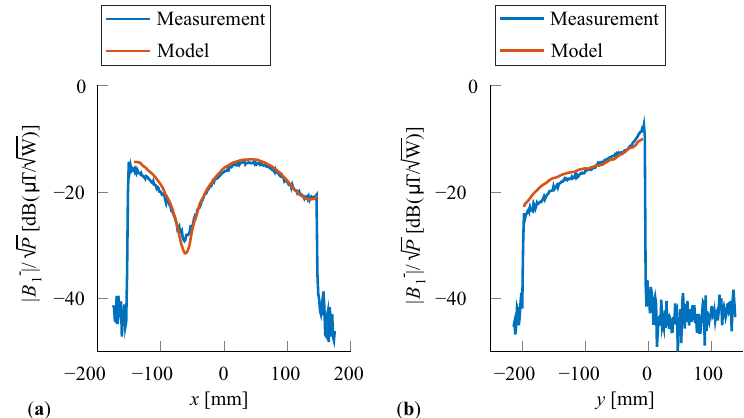
√ (cid:12) ( r ) (cid:12) (cid:12) / P of the four-channel coil of measurement and model for (cid:12) B − √ 1 W/µT: ( a ) y 0 = − 100mm, ( b ) x 0 = 0mm. The parameters of the